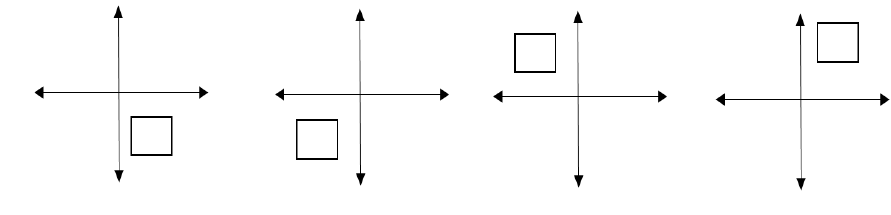
Figure 7. One quadrant fuzzy area.